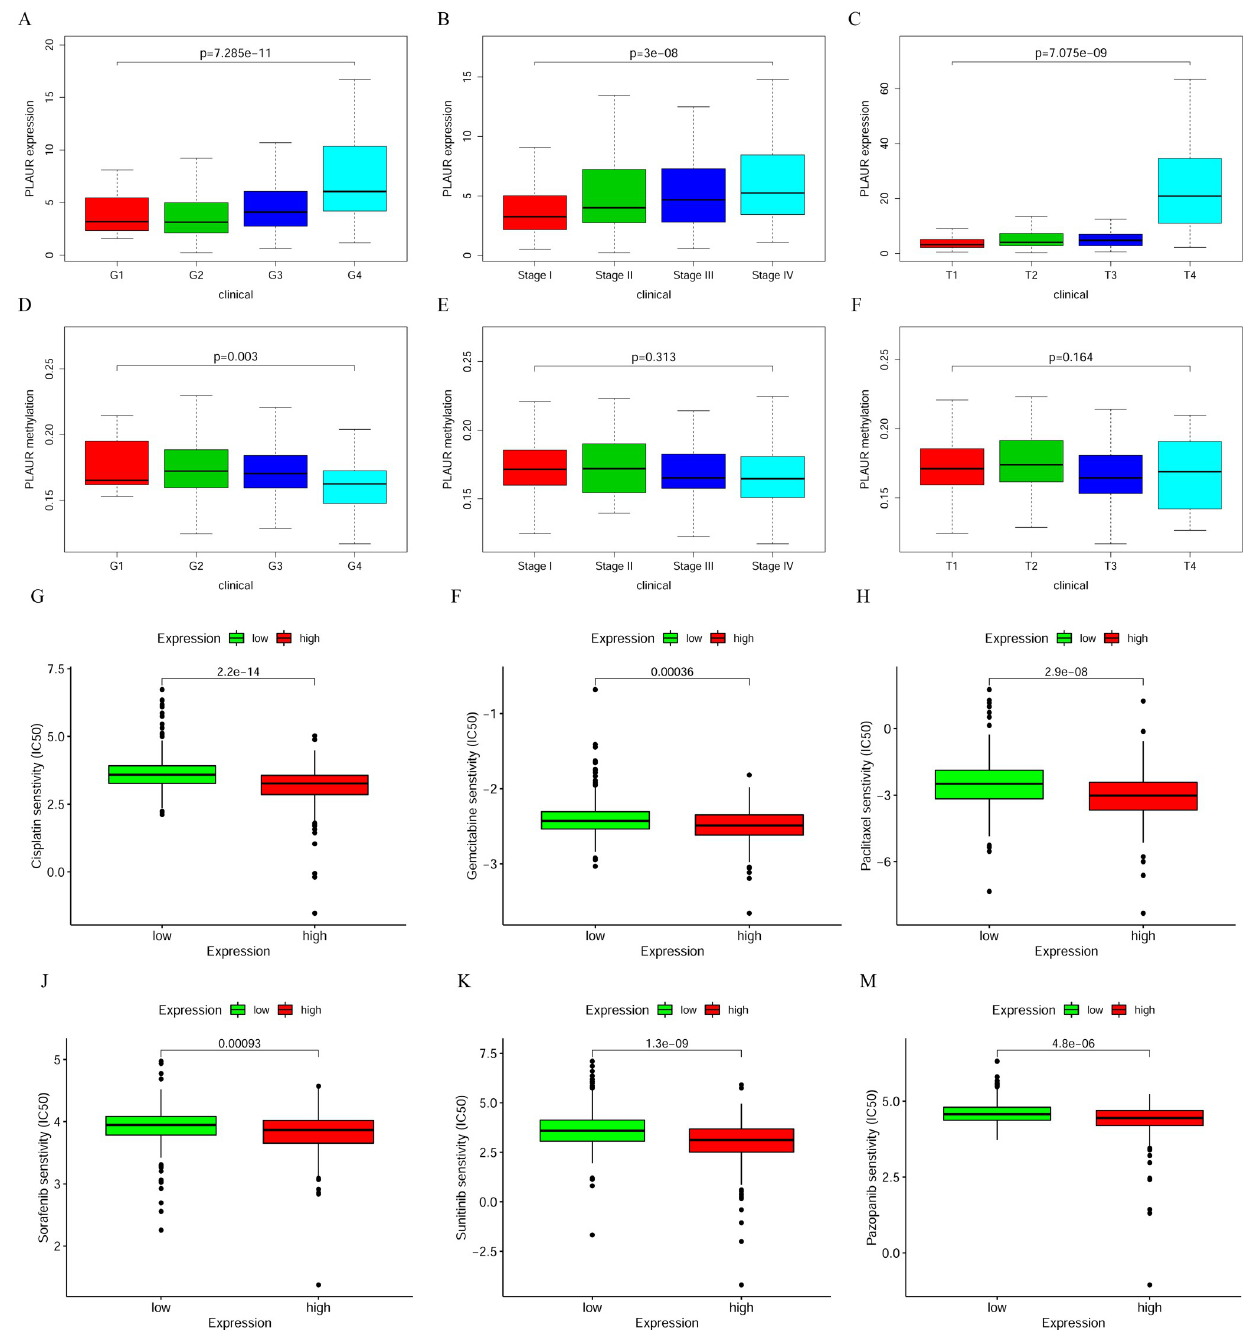
Fig 3. Analysis of the relationship between the expression of PLAUR and the clinical characteristics of patients. Analysis of the correlation between PLAUR expression and ccRCC progression (A-F) and its correlation with chemosensitivity (G-M).